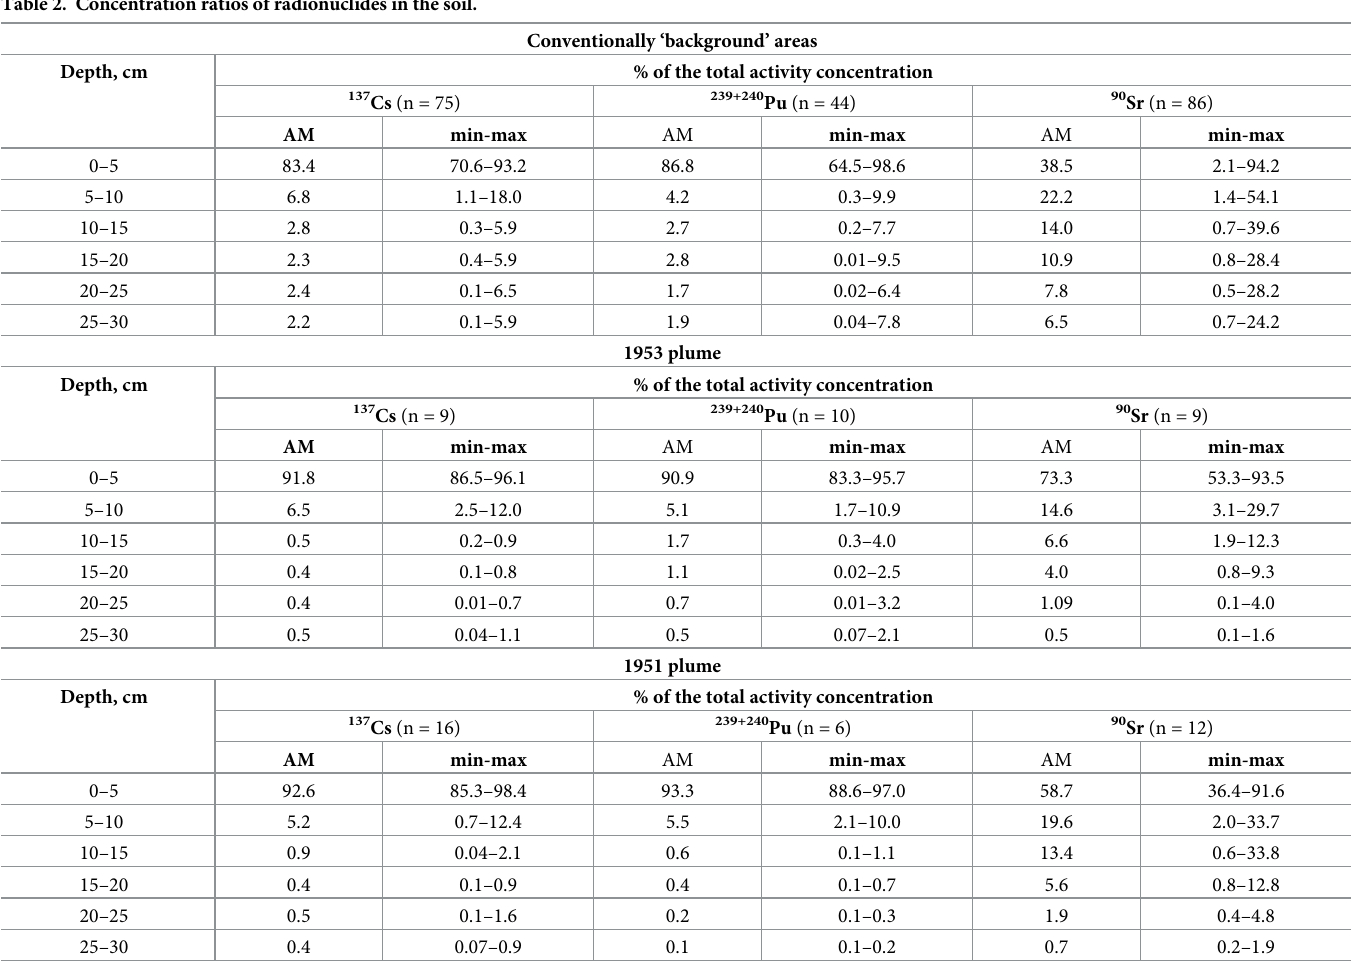
Table 2. Concentration ratios of radionuclides in the